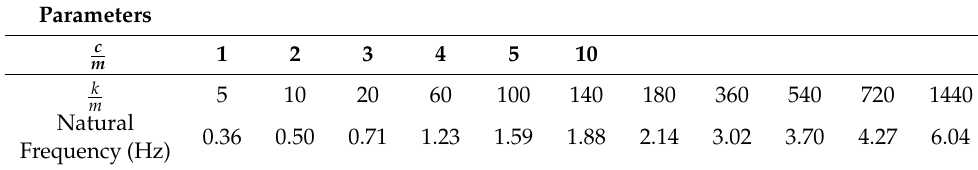
Table 1. The parameters for identification.